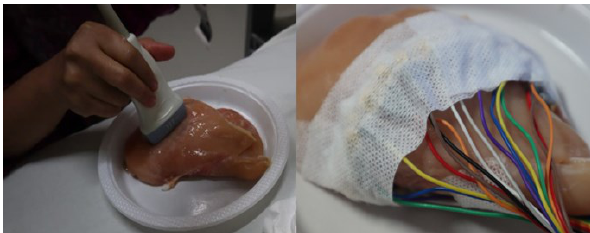
Fig.2: Ultrasound of chicken meat phantom using linear transducer and EIT with electrodes.